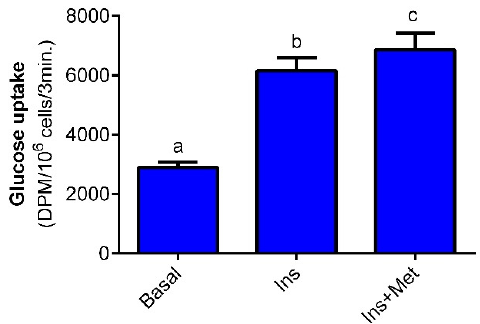
Figure 2. The effects of metformin on glucose transport into isolated rat adipocytes. Adipocytes were incubated in buffer containing 0.5 mM glucose, 2-deoxy-D-glucose-[1- 14 C], 3% BSA, and 10 mM HEPES. First, cells were preincubated for 10 min without metformin or in the presence of 1 mM metformin. Then, 10 nM insulin was added to both groups (Ins and Ins + Met). The additional group of cells (Basal) was preincubated with 0.5 mM glucose without insulin. After 20 min, 2-deoxy-D-glucose-[1- 14 C] was added and incubations were performed for 3 min. Finally, the radioactivity derived from 2-deoxy-D-glucose-[1- 14 C] into adipocytes was measured. Ins—insulin, Met—metformin, DPM—disintegrations per minute. The obtained results represent the mean ± SEM from 3 independent experiments in 5 repetitions ( n = 15). Values marked by different letters differ significantly at p < 0.05.